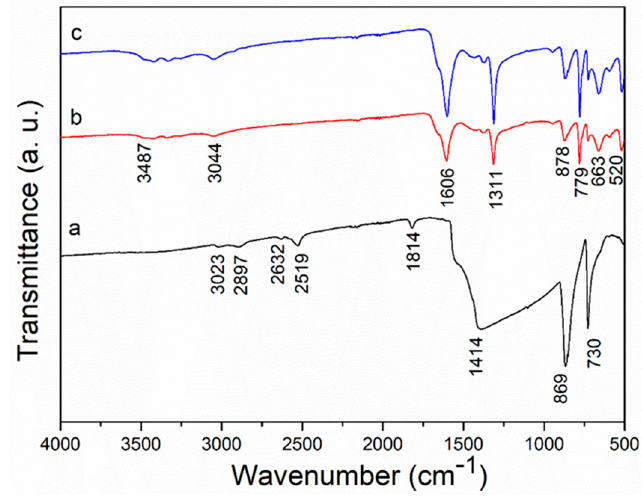
Figure 5. FT ‐ IR spectra of the untreated and treated samples: ( a ) UT, ( b ) AO, ( c ) 0.02 mol/L CA.